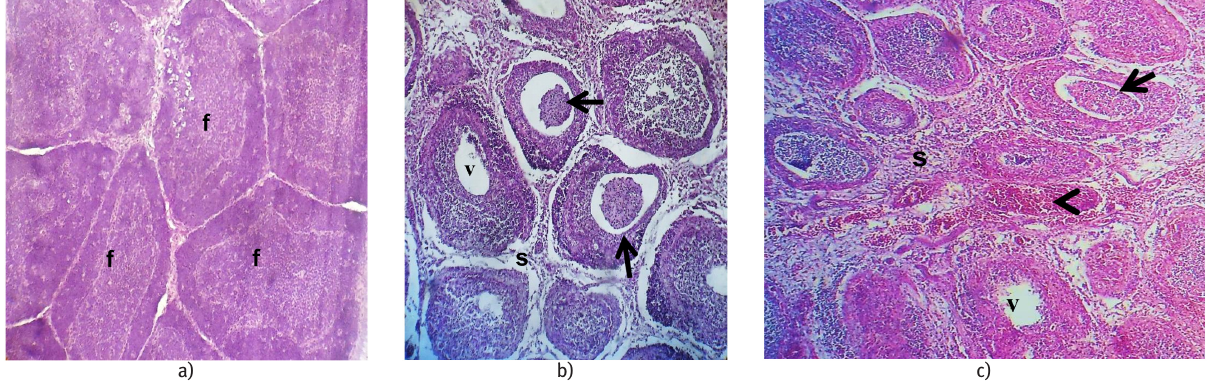
Figure 6: Photomicrograph of section of bursae of chickens post-inoculation and/or exposure to a very virulent infectious bursal disease virus. Note intact follicles (f) in uninoculated chicken (a); vacuolations (v), depletion of follicular cortices and medullae (arrows), haemor- rhage (arrow heads) and thickened interfollicular spaces (s) in inoculated (b) and sentinel (c) chickens. H & E x